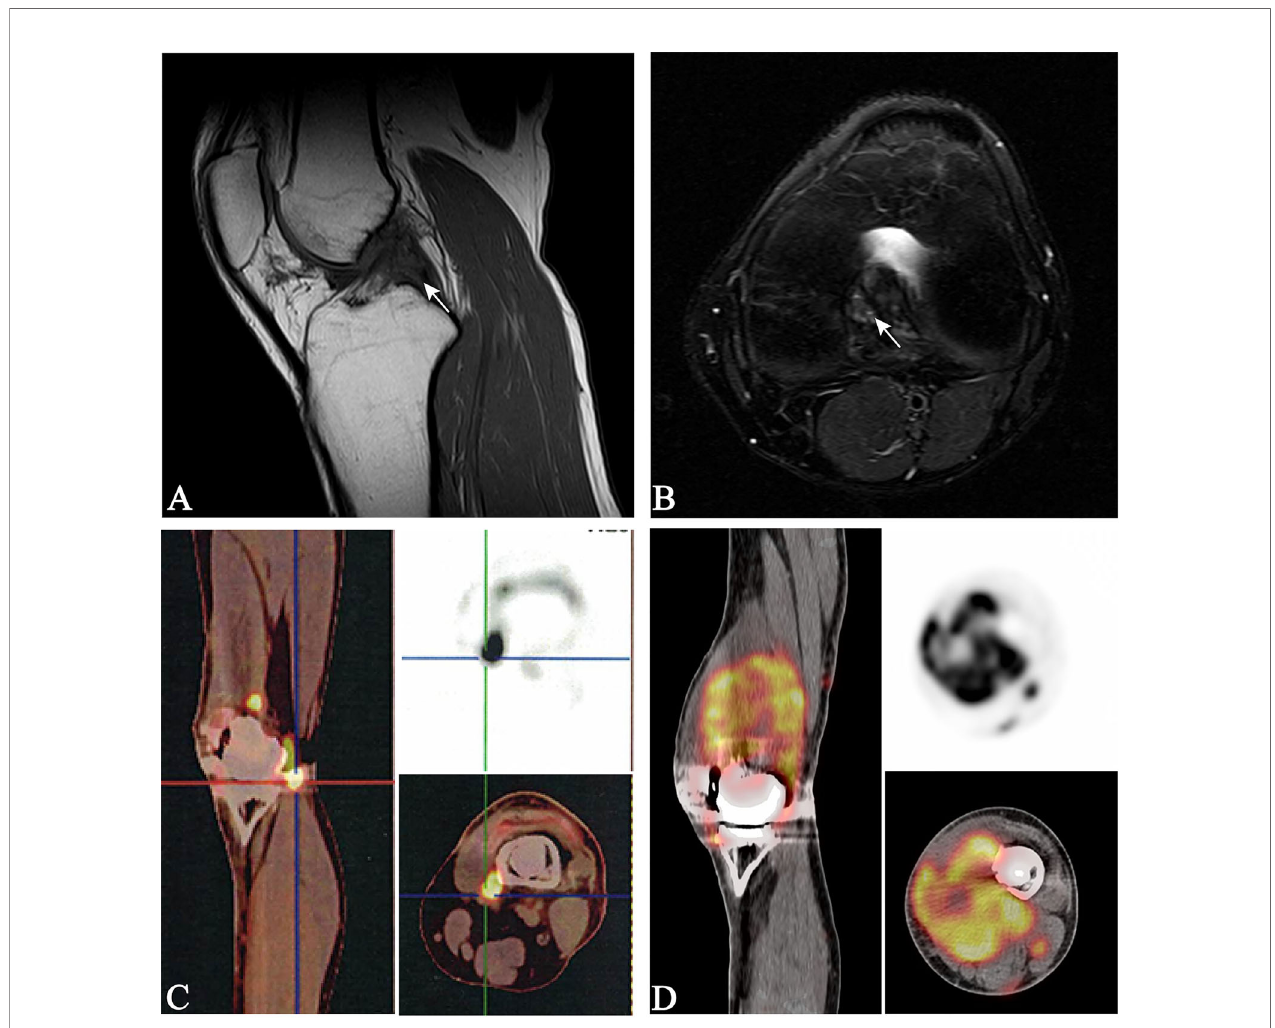
FIGURE 1 | Magnetic resonance imaging of the left knee (A, B) , white arrows indicate a mass measuring 2.8 × 3.8 cm violating the cruciate ligaments; positron emission tomography-computed tomography (PET-CT) (C) , the fl uorodeoxyglucose-avid tumour is seen within the left knee, indicating tumour recurrence; PET-CT (D) , the fl uorodeoxyglucose-avid tumour is presented on maximum intensity projection image as increased uptake around the left knee, indicating a second tumour